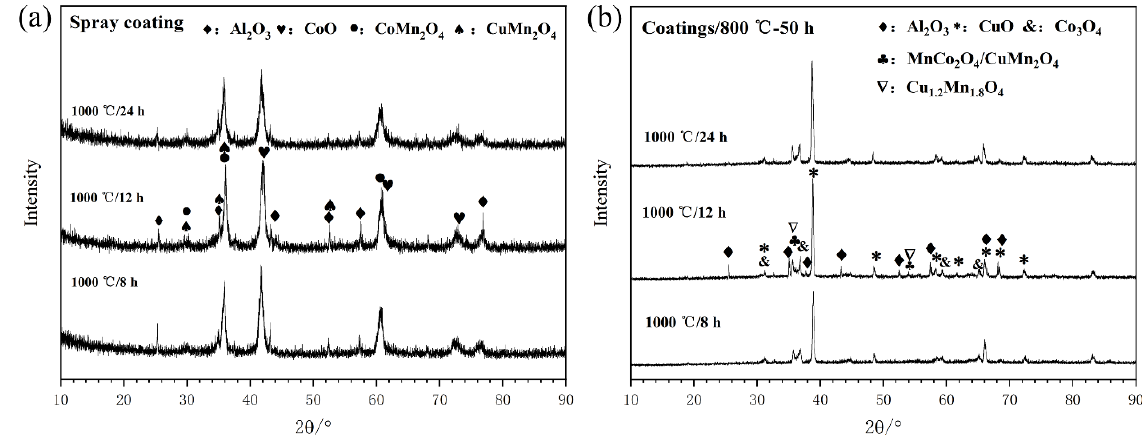
Figure 10. XRD patterns of coatings prepared with sintering powder for different times: ( a ) spray state; ( b ) coatings at 800 °C for 50 h.